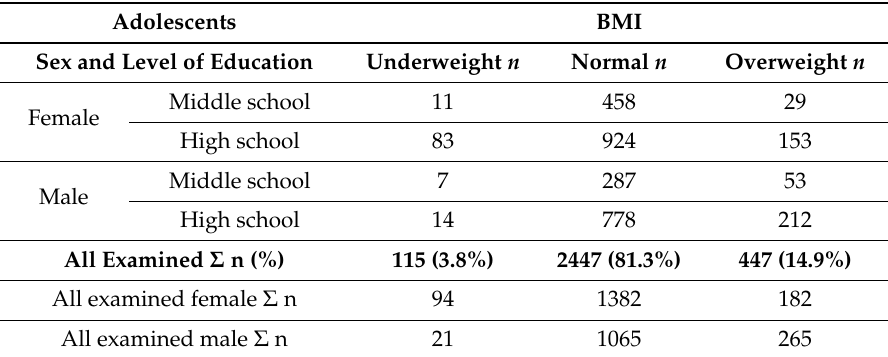
Table 2. BMI range in examined adolescents from middle and high schools. Adolescents BMI Underweight n Normal